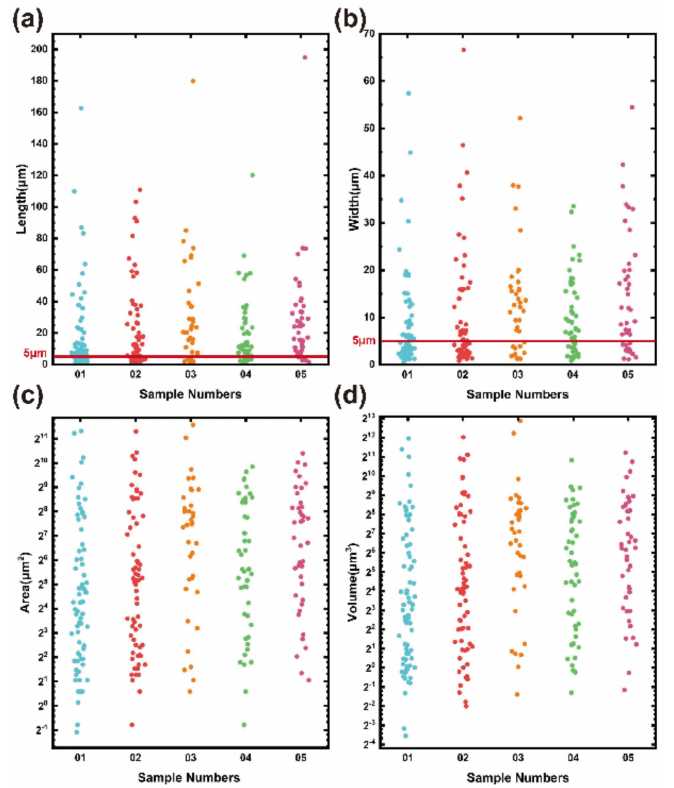
Figure 6. Length, width, area, and volume of cellulose particles: ( a ) length of cellulose particles; ( b ) width of cellulose particles; ( c ) area of cellulose particles; ( d ) volume of cellulose particles. As can be seen from the red line in Figure 7, the length and volume of the cellulose particles had a proportional relationship; generally, the length increased with volume, but the volume information of cellulose particles could not be represented by the length information of the cellulose particles. From the yellow dashed line in Figure 7, it can be seen that the volume of cellulose particles with similar lengths often differed greatly.